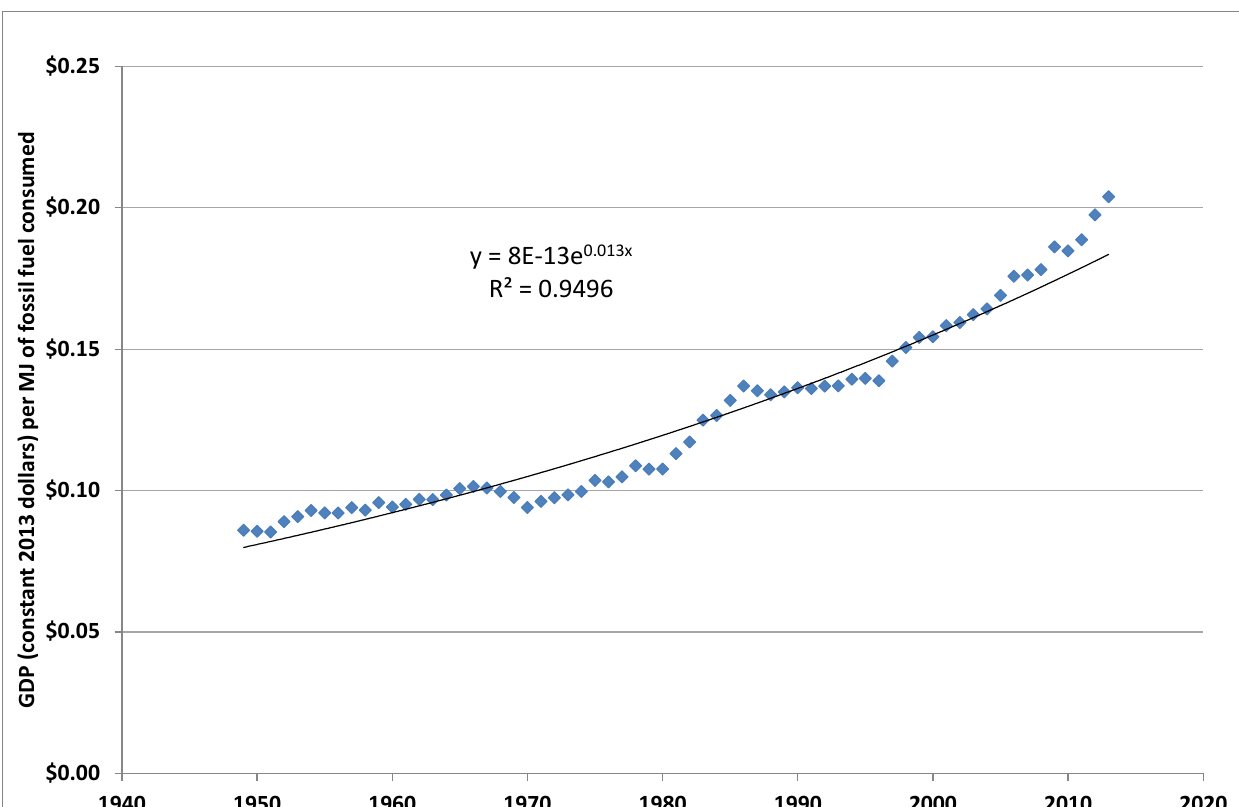
Figure 5. Dollars of GDP per megajoule of fossil fuel consumed, and best-fitting exponential trend; constant 2013 dollars.